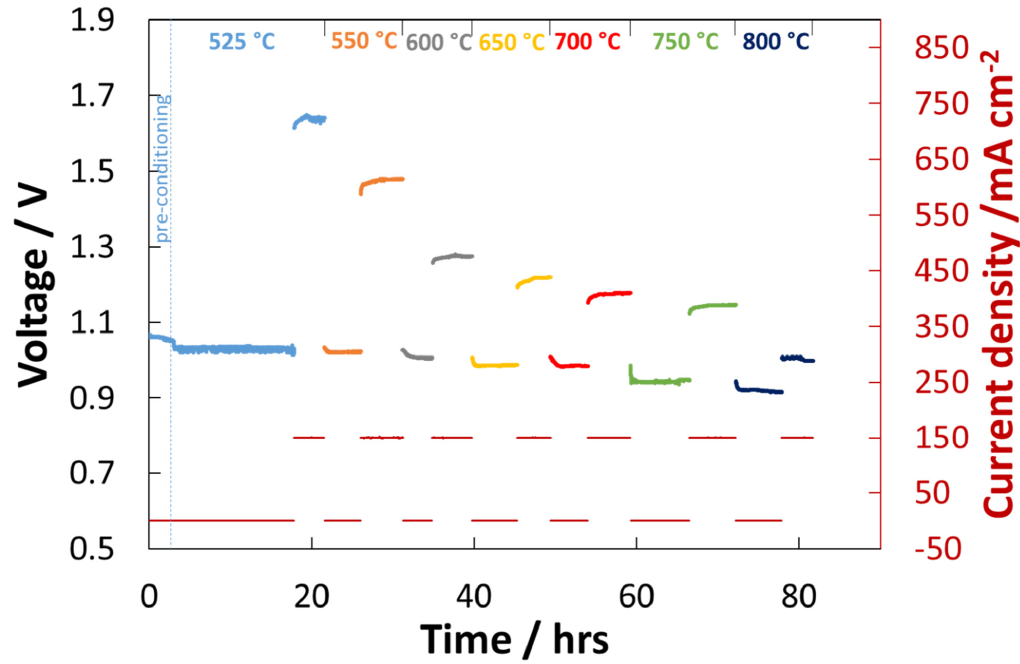
Figure 1. Life-time test for the coated cell investigated in the temperature range 525–800 °C for the co-electrolysis of H 2 O and CO 2 . Table 1. Most relevant electrochemical results achieved with bare and coated